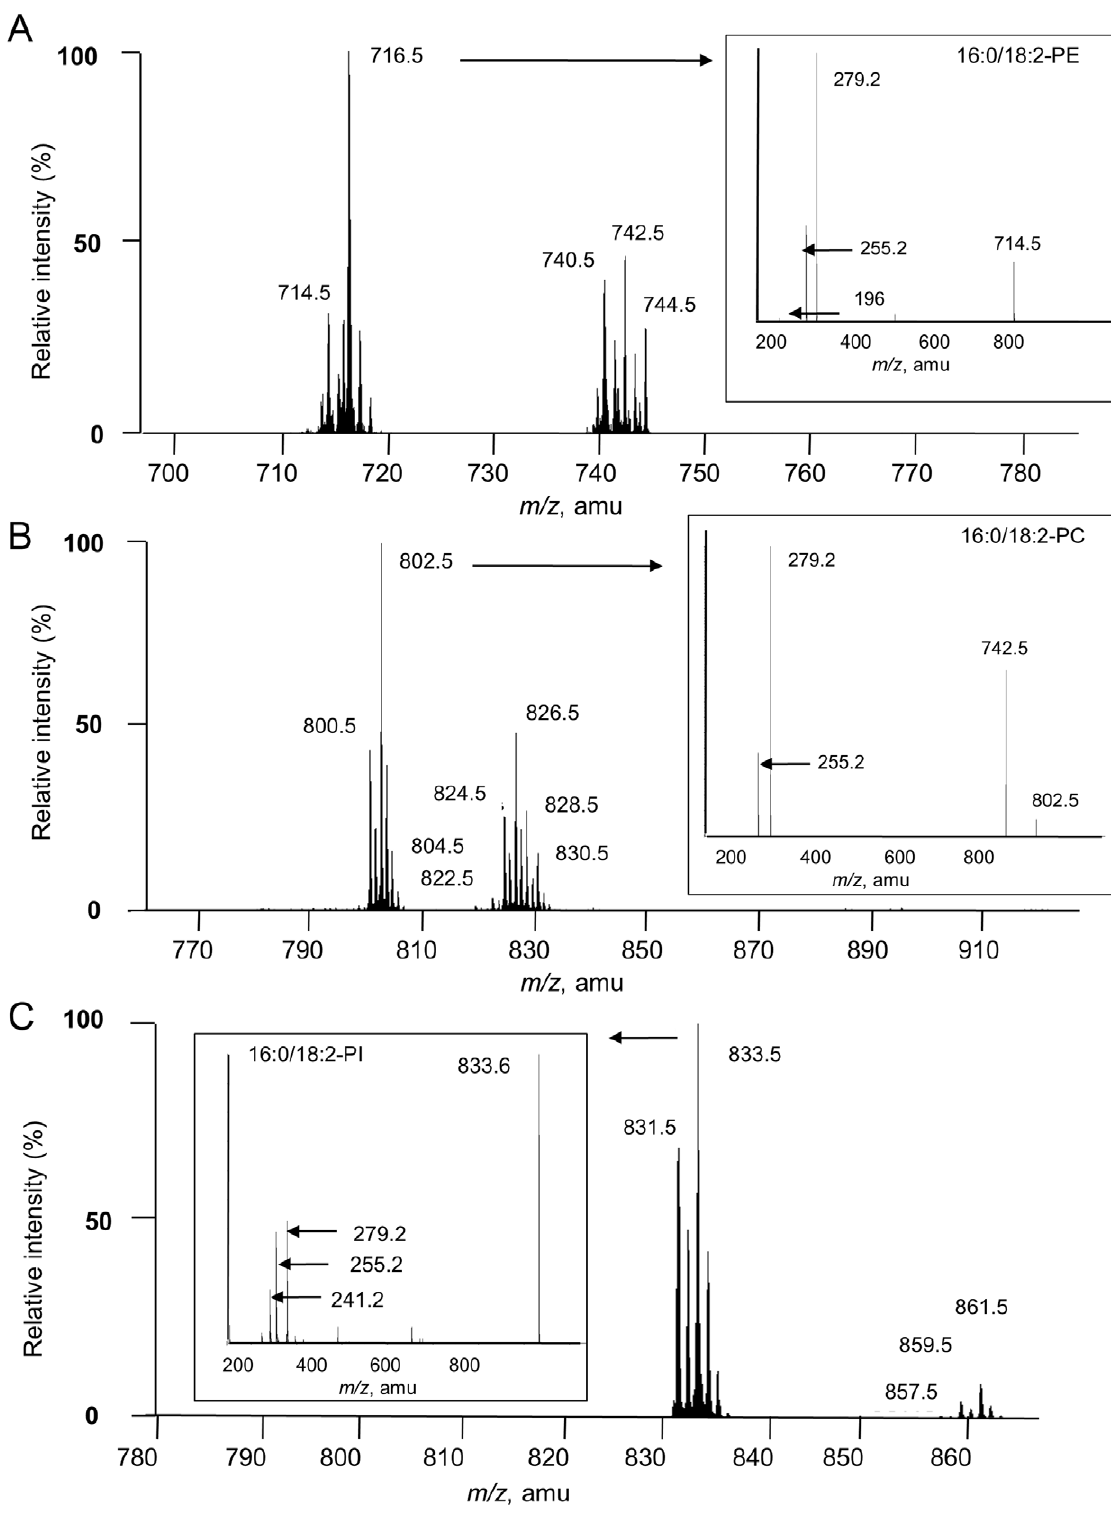
Figure 1. Mass scan of the main glycerophospholipids in suspension cells. Mass spectra of parent ions of phosphatidylethanolamine (A), phosphatidylcholine (B) and phosphatidylinositol (C) were recorded by the neutral loss of fragment 141 amu (from positive ions), the neutral loss of fragment 60 amu (from negative ions) and the precursors of fragment m/z 241 (from negative ions), respectively. Mass spectra correspond to the [M + H] + ions for PE, [M + HCOO] 2 for PC and [M 2 H] 2 ions for PI. The glycerophospholipid fatty acid composition was determined in the negative mode by CID as shown (insert) for 16:0/18:2-molecular species.